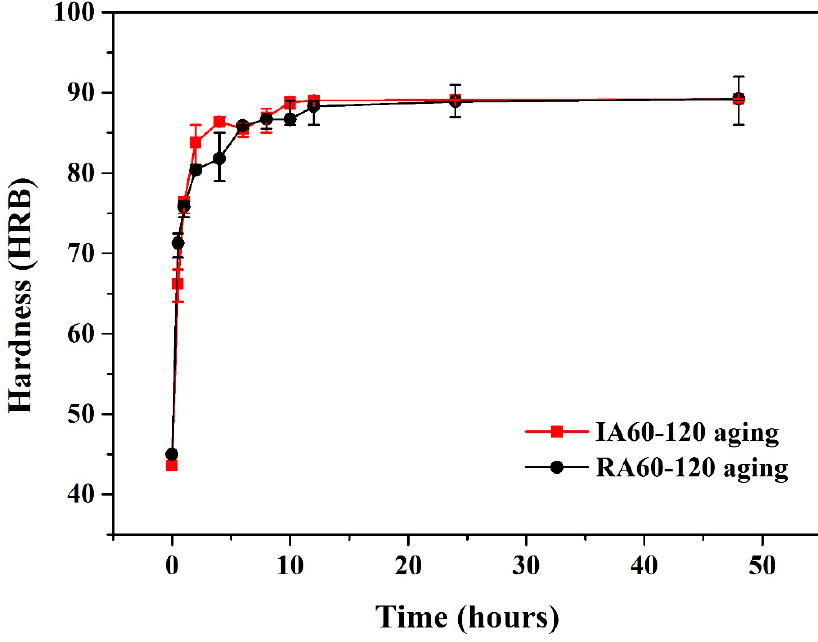
Figure 9. Effect of aging temperature and aging method on hardness profiles of specimens.